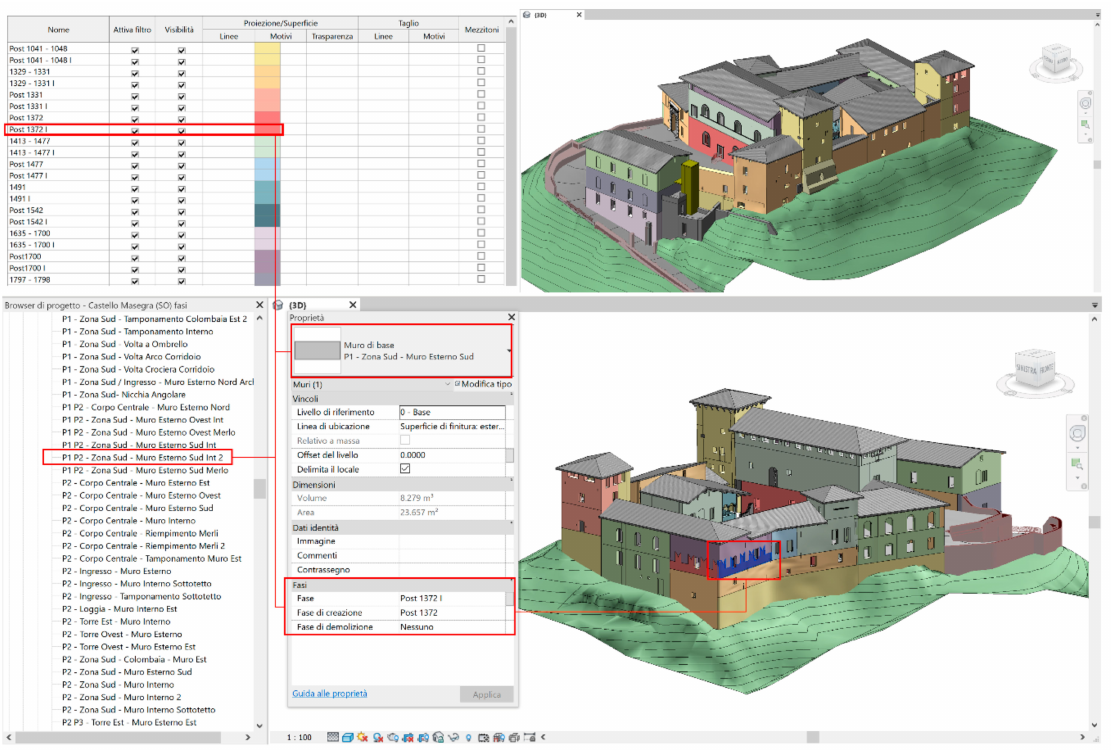
Figure 13. Management of historical phases in HBIM project of Masegra